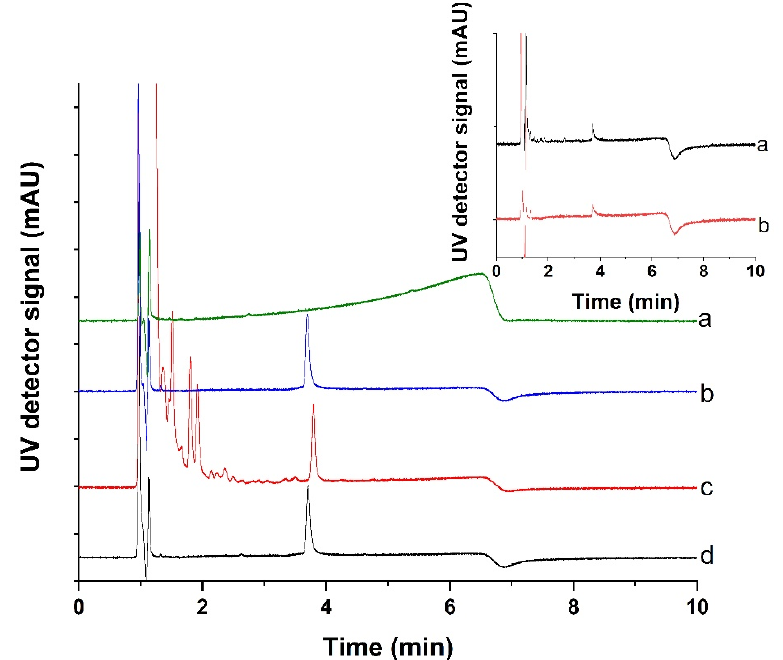
Figure 10. Chromatograms of a ten-times diluted blank urine sample after pretreatment ( a ), a 10 µg/mL lysozyme standard ( b ), a 10 µg/mL diluted urine sample without sample pretreatment ( c ) and a pretreated 10 µg/mL diluted urine sample ( d ). (The retention time of lysozyme is 3.7 min). The inset shows the chromatogram of a 2.5 µg/mL diluted urine sample after pretreatment (LLOQ